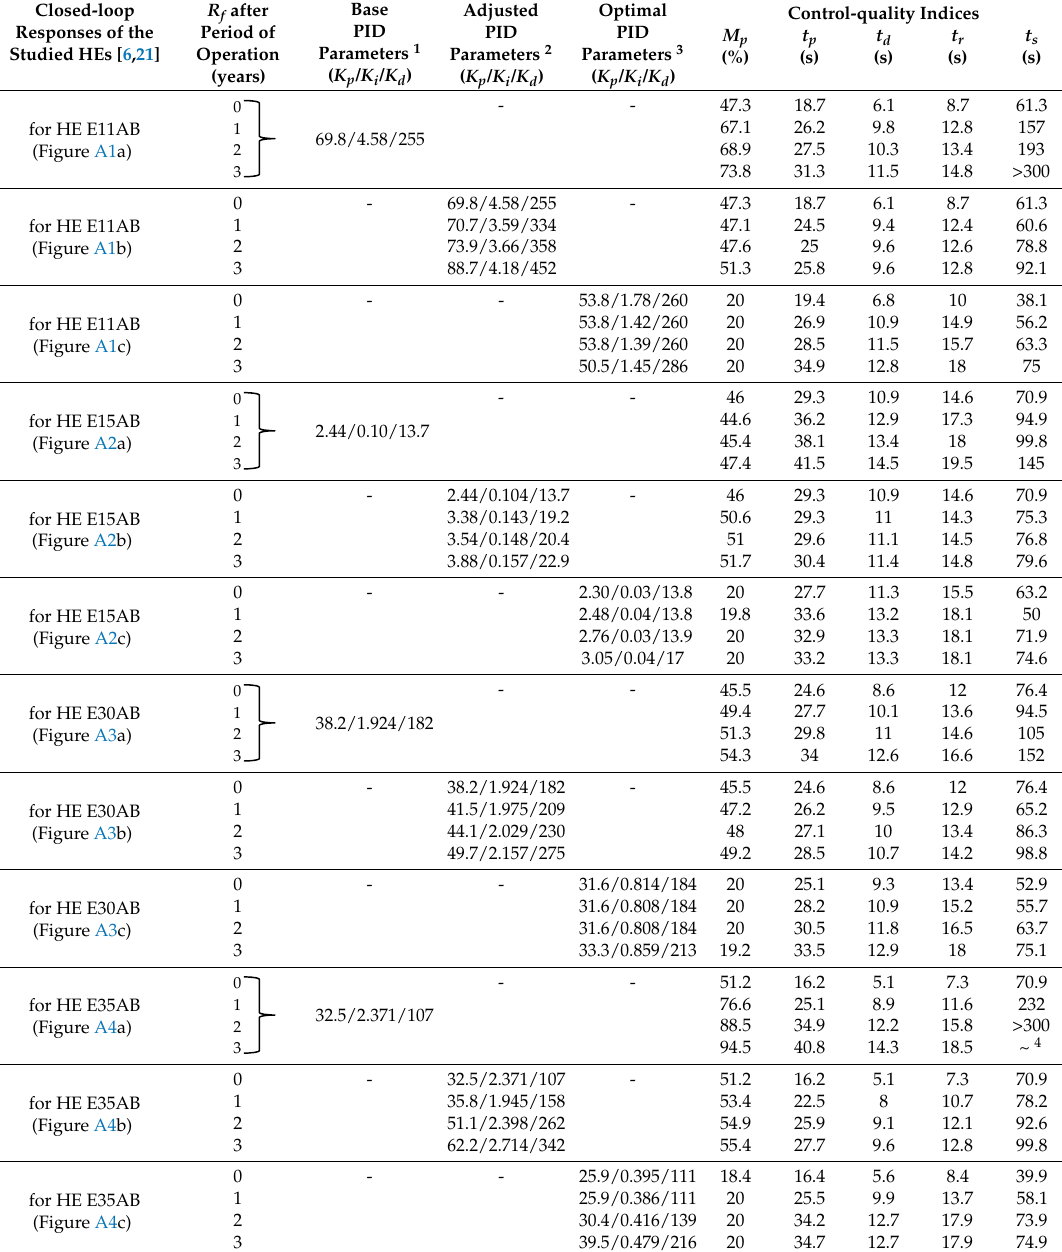
Figure A4. Closed-loop step responses (case in work [6]) under fouling conditions of the HE E35AB models: without adjustment ( a ) after adjustment ( b ) and after adjustment of optimal ( c ) PID tuning parameters. Table A1. Values of the control-quality indices for used sets of the PID parameters in different periods of operation (cases in work [6]).